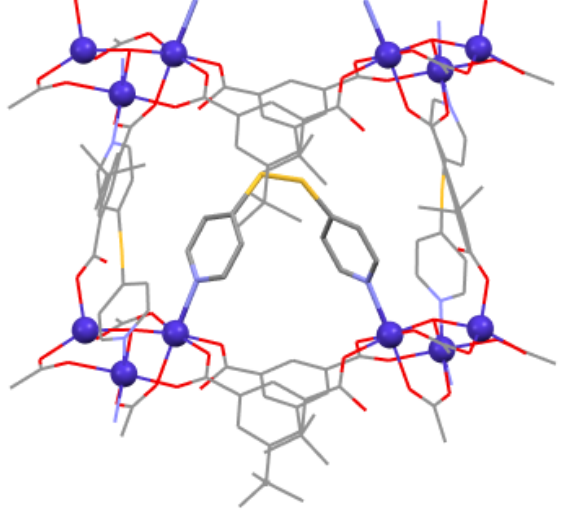
Figure 21. Section of the crystal structure of [Co ] (GUXPIZ), viewed approximately along the [100] ( μ - dtdp ) 0.5 n